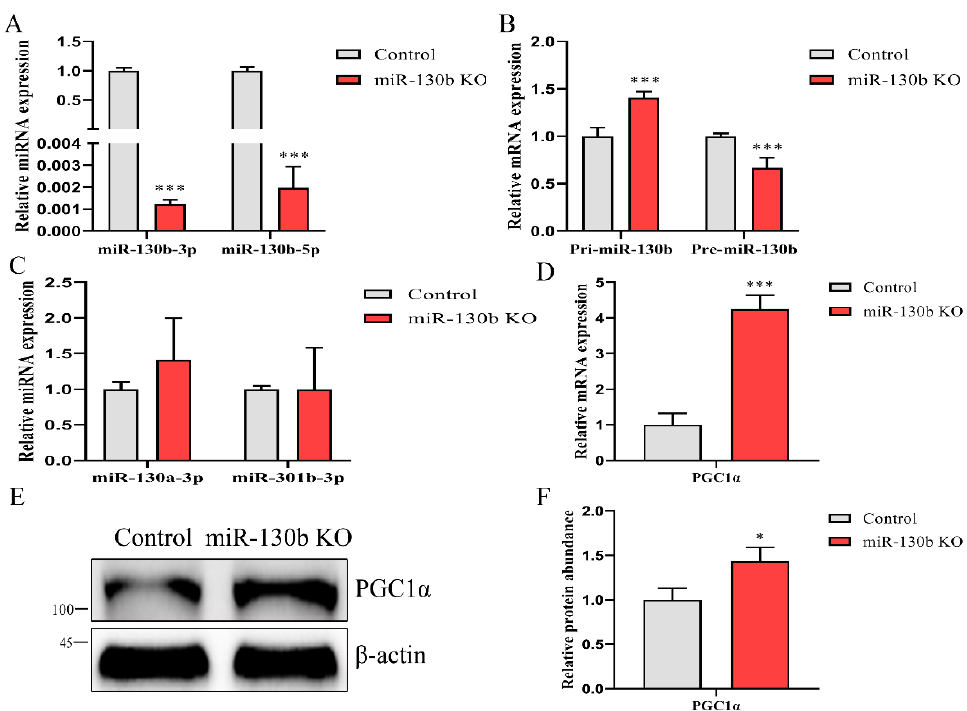
Figure 2. Knocking out miR-130b decreases miR-130b-3p and 5p abundance and promotes PGC1 α expression. ( A ) Detecting the abundance of miR-130b-3p and 5p by RT-qPCR in control and miR-130b KO cells. ( B ) Abundance analysis of pri-miR-130b and pre-miR-130b in these two cells. ( C ) Expression detection of miR-130a-3p and miR-301b-3p in KO cells. ( D ) mRNA expression analysis of PGC1 α in miR-130b KO and control cells. ( E , F ) Detection of PGC1 α protein abundance in control and KO cells by Western blot. Data are shown as mean ± SEM. p < 0.05 and p < 0.001 are indicated as * and ***.